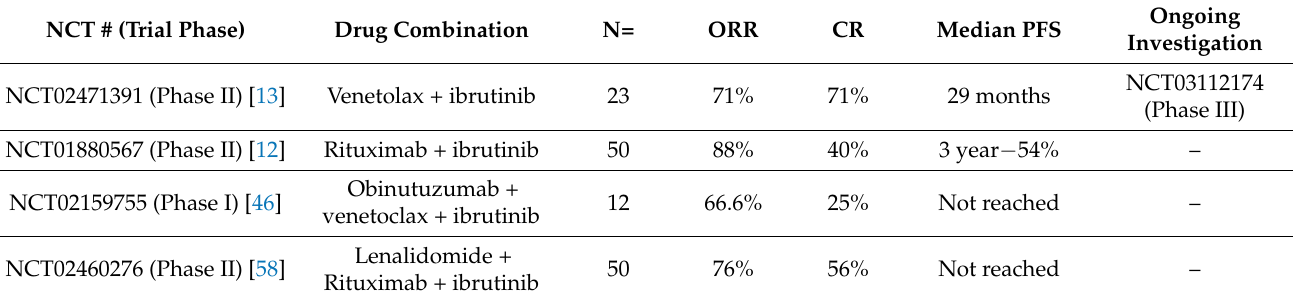
Table 2. Combination strategies to overcome ibrutinib resistance/failure for R/R